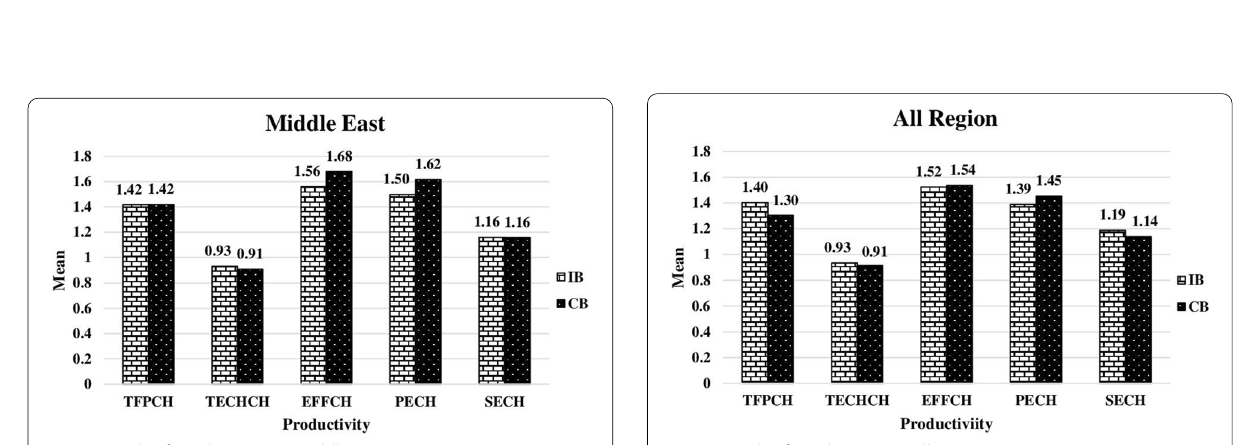
Fig. 6 Levels of productivity in Middle East